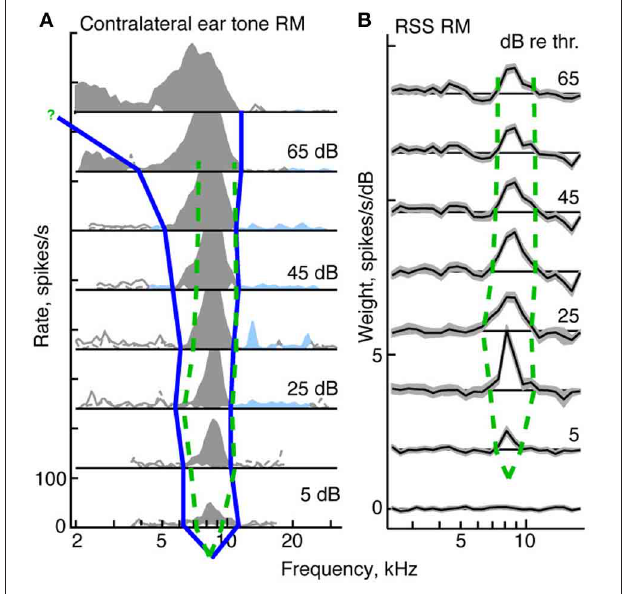
The blue curve shows the tuning curve edges for the tone response map, derived as described in the text. The green dashed curve in both (A) and (B) shows the edges of the tuning curve for the weight-function map. (B) Weight-function map for the same neuron. The dB scale in both parts is dB re threshold for BF tones (A) or RSS stimuli (B) . The tuning curve near the BF tip is not well specified by the response maps. For the tone response maps, the threshold at BF is determined from a rate-level function; for the weight-function maps, the threshold is set halfway between levels that do and do not produce weights that are significantly different than